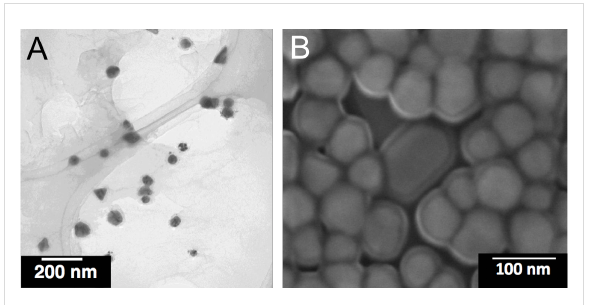
Figure 1: Representative transmission (A) and scanning electron (B) images of PVP-coated AgNP.